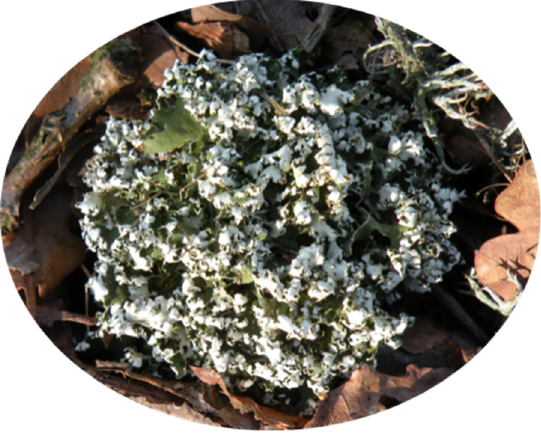
Figure 4. Cladonia foliacea , photo snapped.